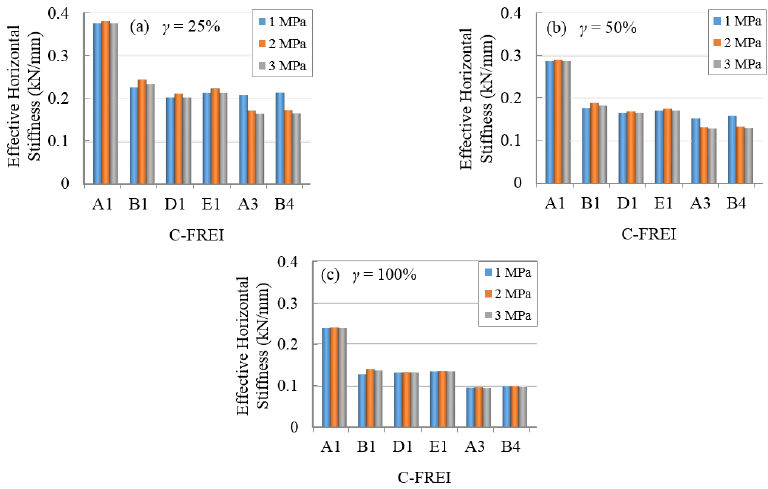
Figure 8. Effective horizontal stiffness of C-FREIs under different vertical pressures (1, 2, and 3 MPa) and shear strains of ( a ) 25%; ( b ) 50%; and ( c )